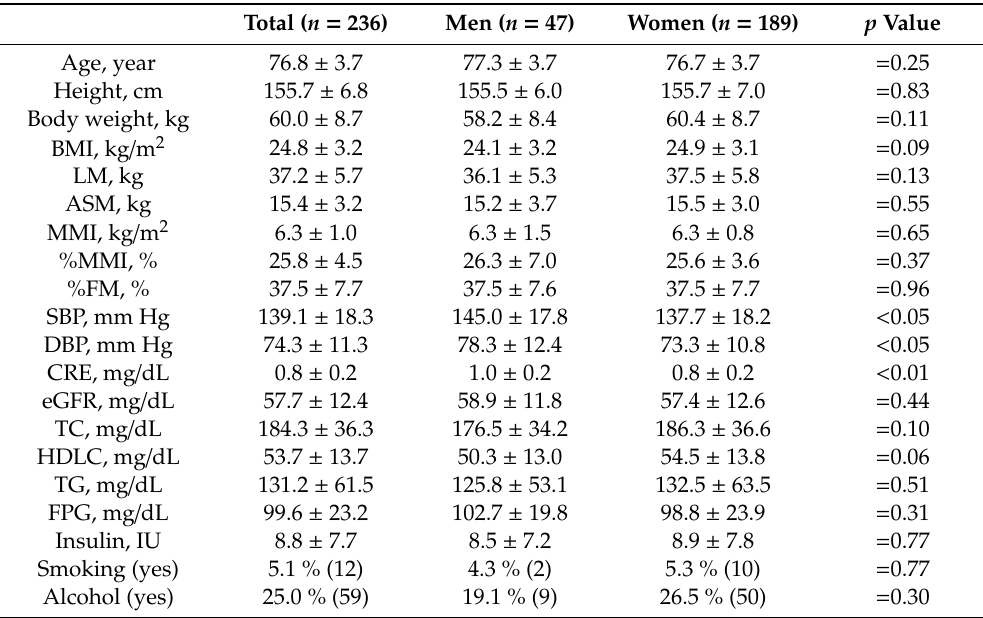
Table 1. Characteristics of the study participants and the di ff erences between men and women. Total ( n = 236)